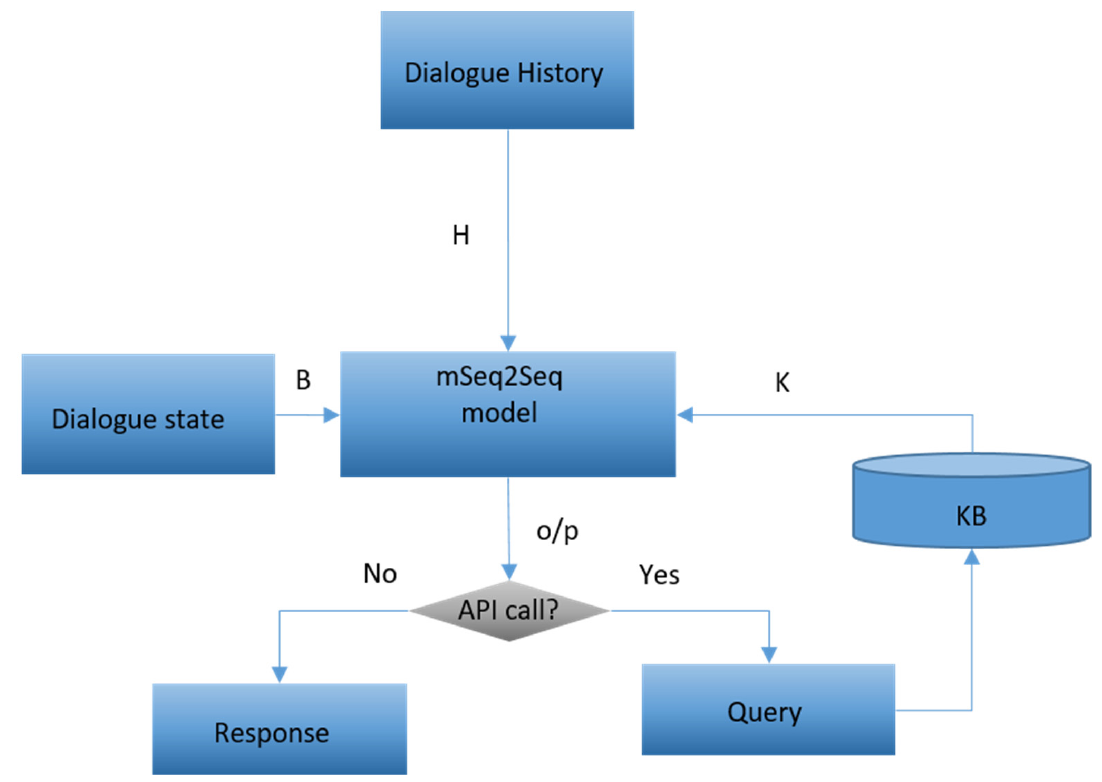
Figure 1. The multi-lingual Seq2Seq model workflow. Figure 2. The multi-lingual Seq2Seq model